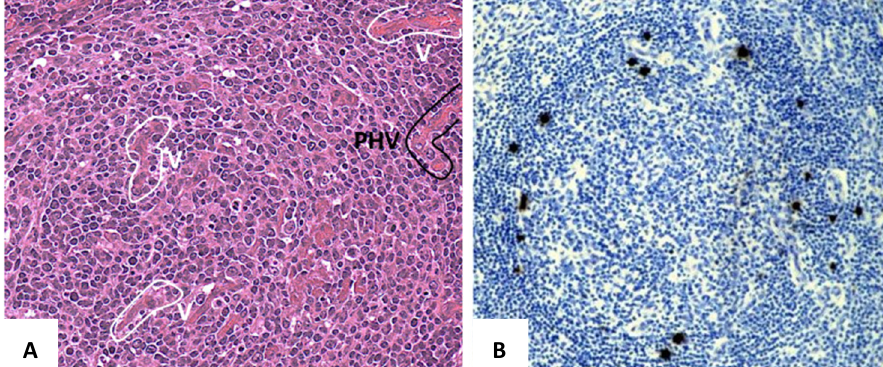
Figure 1. KSHV/HHV8-associated MCD. ( A ) There is a marked intrafollicular vascular proliferation (V). The lymphoid follicle also has typical penetrating hyalinised vessels (PHV). ( B ) In the follicular mantle, some large atypical cells, consistent with plasmablasts, are positive for KSHV/HHV8 viral IL-6. Magnification ×20 ( A , B ).